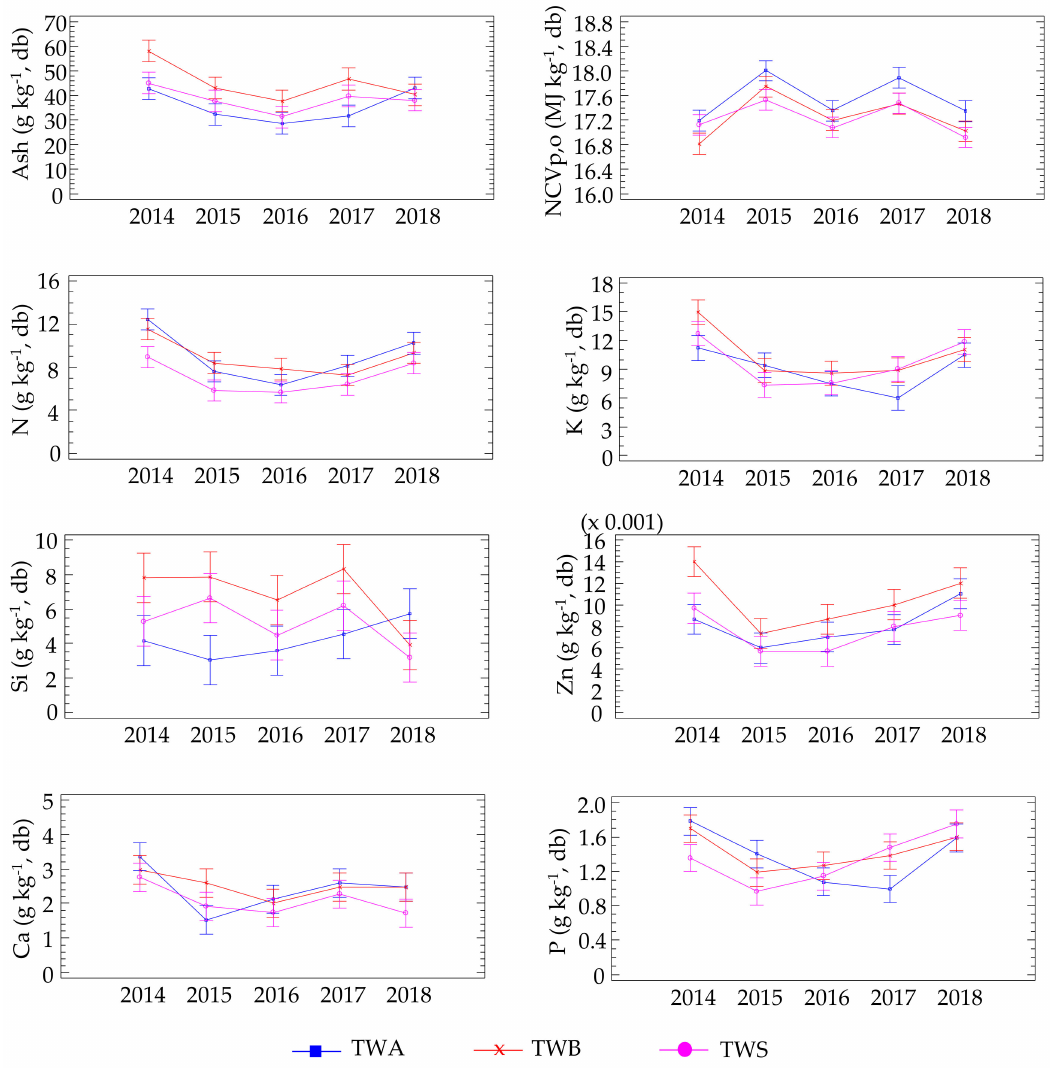
Figure 5. Net calorific value, ash, N, P, K, Ca, Si, and Zn contents across cultivars and years for the biomass cultivated in AL fields. Means and Fisher´s LSD interaction